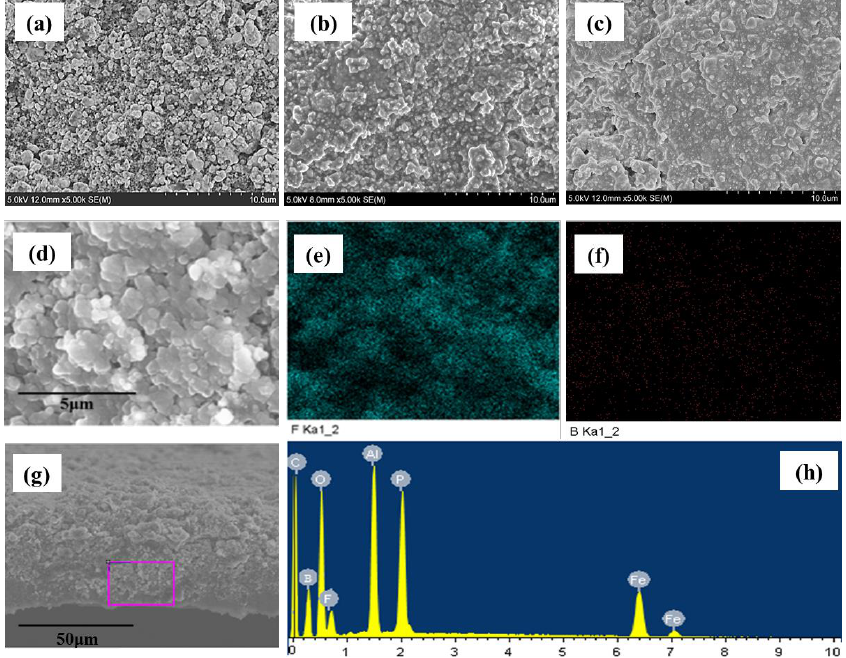
Figure 10. SEM images of the surfaces of ( a ) the original LiFePO 4 electrode, ( b ) the LiFePO 4 electrode before the cycling, and ( c ) the LiFePO 4 electrode after 50 cycles. Elemental mapping results of the surface ( d – f ) and EDX results of the cross section ( g , h ) of LiFePO 4 electrode after 50